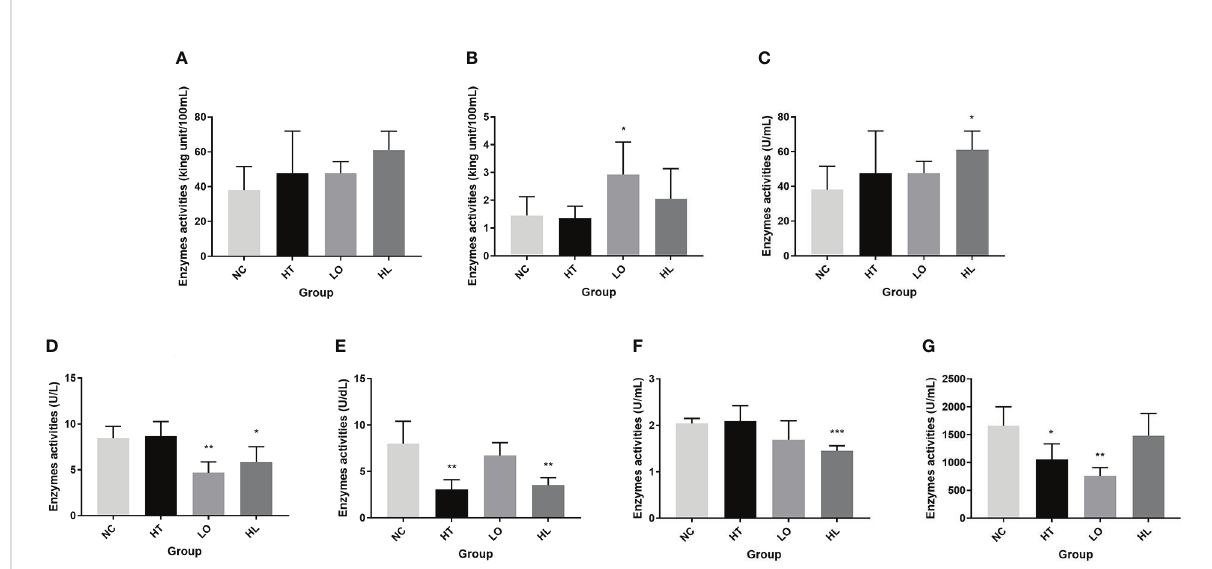
FIGURE 1 Activities of immune and digestive enzymes in A. japonicus under environmental stresses (A) . alkaline phosphatase (AKP); (B) acid phosphatase (ACP); (C) lysozyme (LZM); (D) lipase (LPS); (E) a -amylase (AMS); (F) pepsin (PEP); and (G) trypsin (TRY); *: P < 0.05; **: P < 0.01; ***: P <